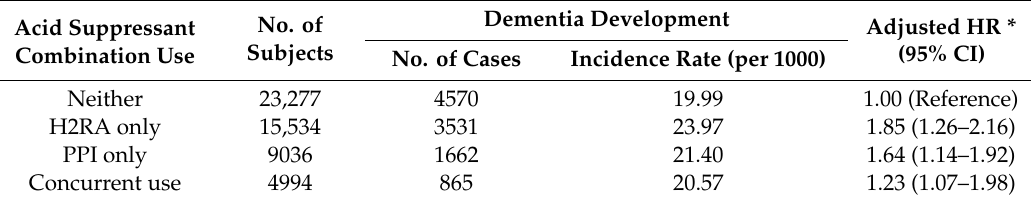
Table 4. Association between acid suppressant combination and dementia